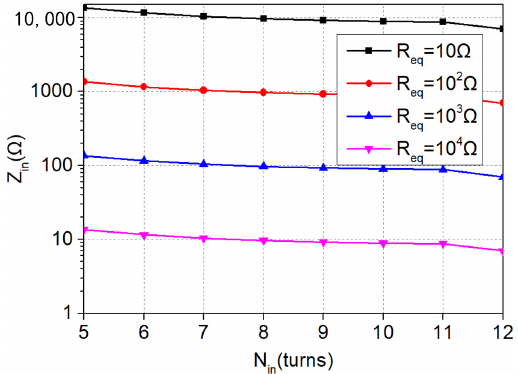
Figure 6. Variation of the equivalent cross-coupling capacitances and mutual inductances. ( a ) Equivalent cross-coupling capacitances. ( b ) Equivalent mutual inductances.